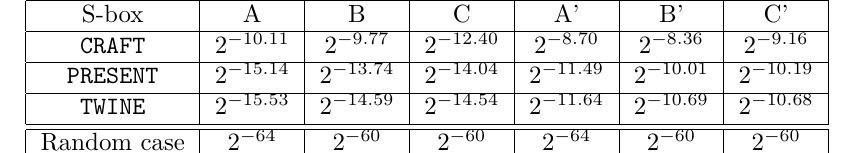
Table 10: The experimental probability of the 7-round boomerang distinguisher in different cases